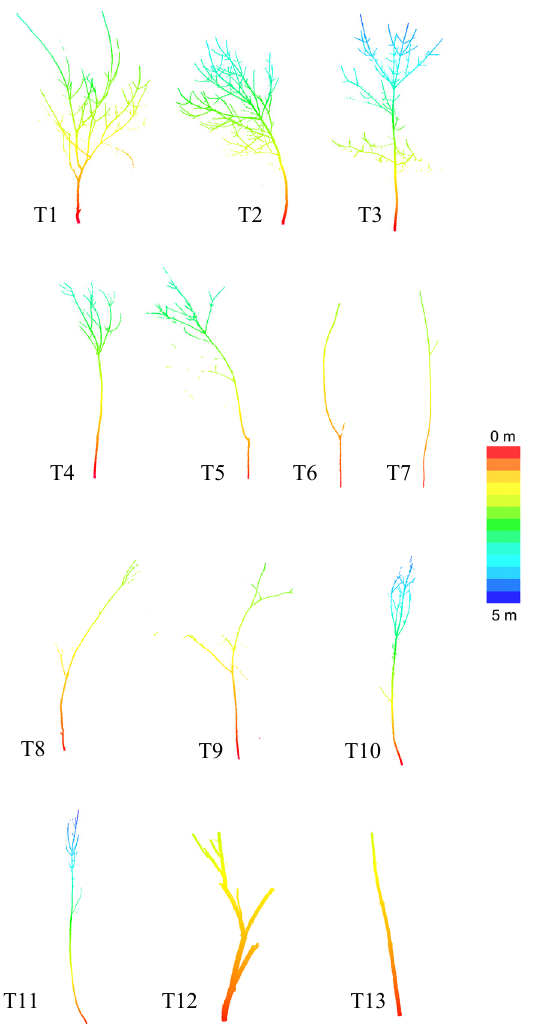
Figure 1. Tree point clouds of data set